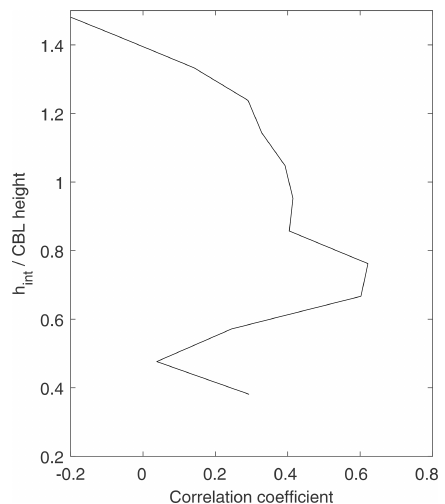
Figure 6. Correlation between 10 ◦ sector estimates of term II of Eq. (2) and the slant-path-integrated water vapor at a 30 ◦ elevation and 10 ◦ azimuth steps. h int is the maximum height of the slant path that is used for the integration and is normalized by the CBL